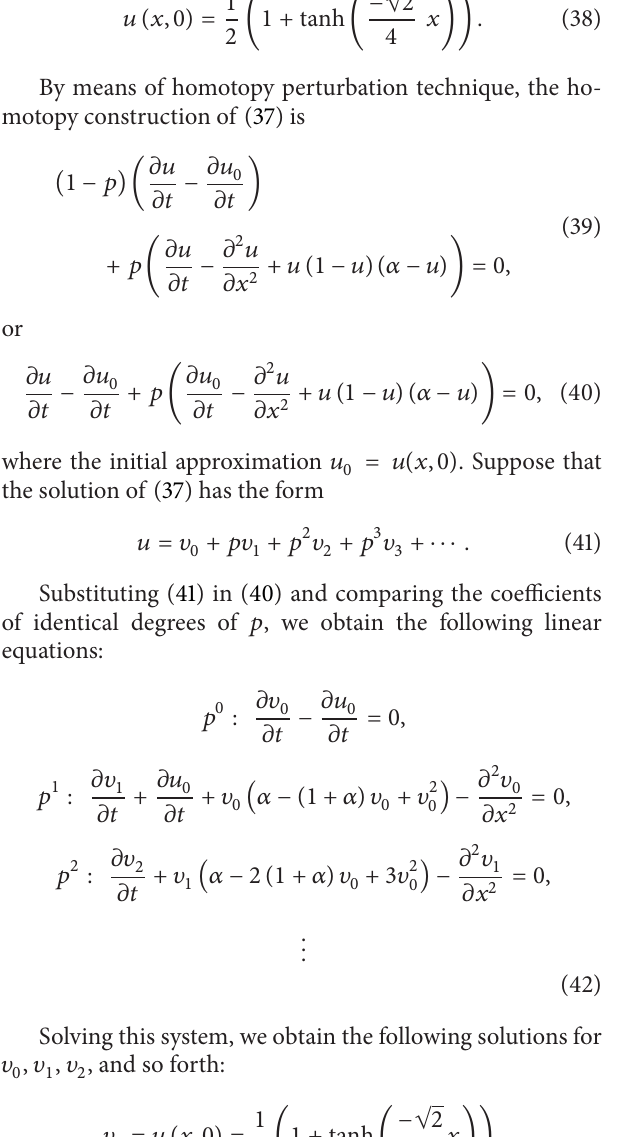
Figure 5: Absolute errors with respect to 𝑢 respectively, for 𝛼 = 1 on (a) and for 𝛼 = 5 on (b) when −8 ≤ 𝑥 ≤ 8 and 0 ≤ 𝑡 ≤ 0.3 , for STO equation, with 𝑛 = 8